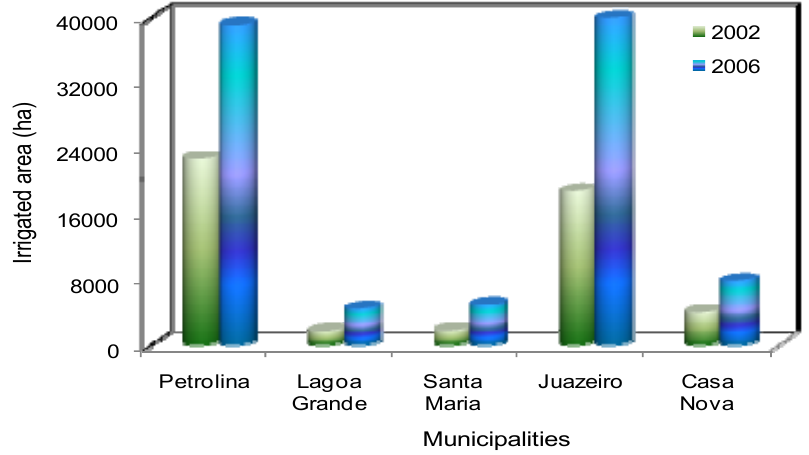
Figure 8. Evolution of irrigated growing areas comprised of the net of agro-meteorological stations, in the Low-Middle São Francisco river basin.